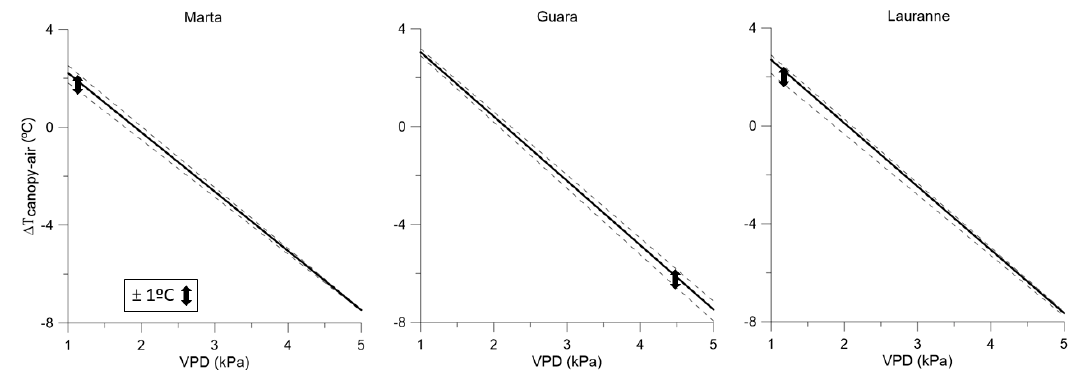
Figure 4. Reference water-stress baselines (rWSB, continuous lines) for cvs. Marta ( A ), Guara ( B ) and Lauranne ( C ). The upper and lower discontinuous lines correspond to the water stress and non-water stress baselines functions defined under sustained deficit irrigation at 65% of the irrigation requirements and fully irrigated conditions, respectively. Black arrows indicate the maximum increment of canopy temperature, with the aim of establishing the threshold limits for irrigation scheduling in the studied almond cultivars.